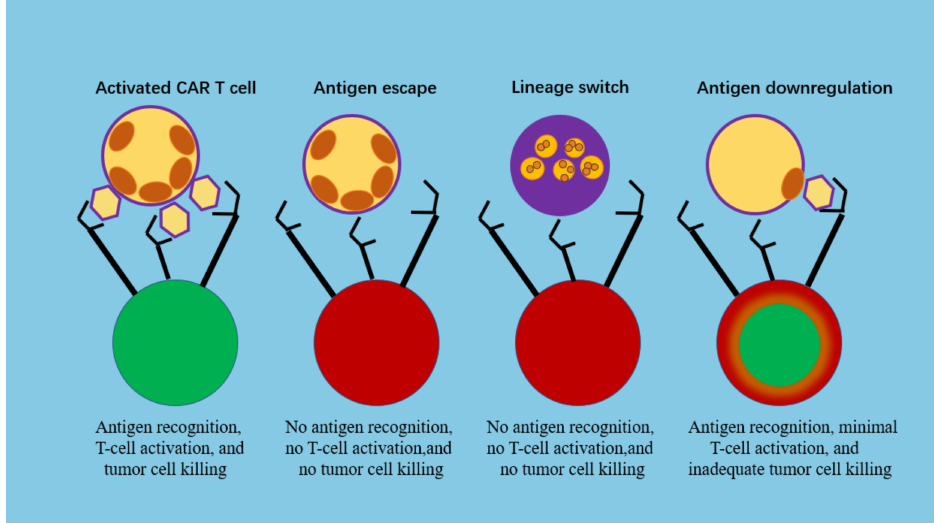
Figure 4. Mechanisms of tumor immune escape.